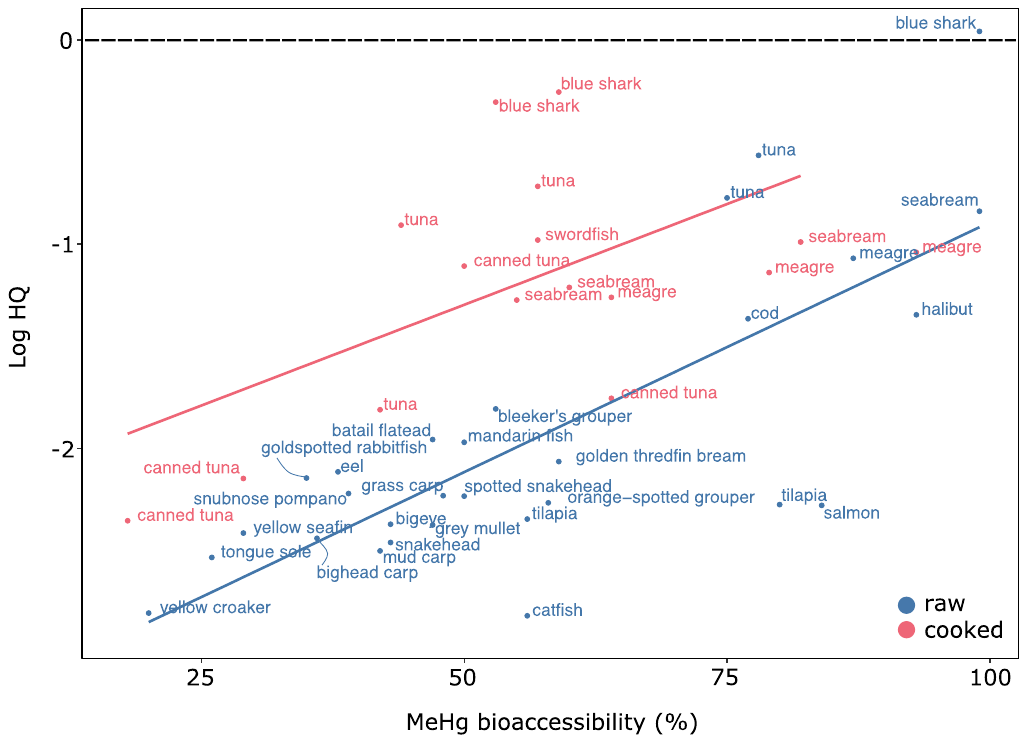
Figure 3. Impact of RAF (expressed as bioaccessibility, %) on HQ. Blue for the raw bioaccessibility value and pink for the cooked one. Dotted line represents HQ = 1. HQ was assessed using the CR-medium consumption and BW of the general population (Table 1). The initial MeHg level in fish flesh and their respective bioaccessibility were obtained from: [37,50–55].